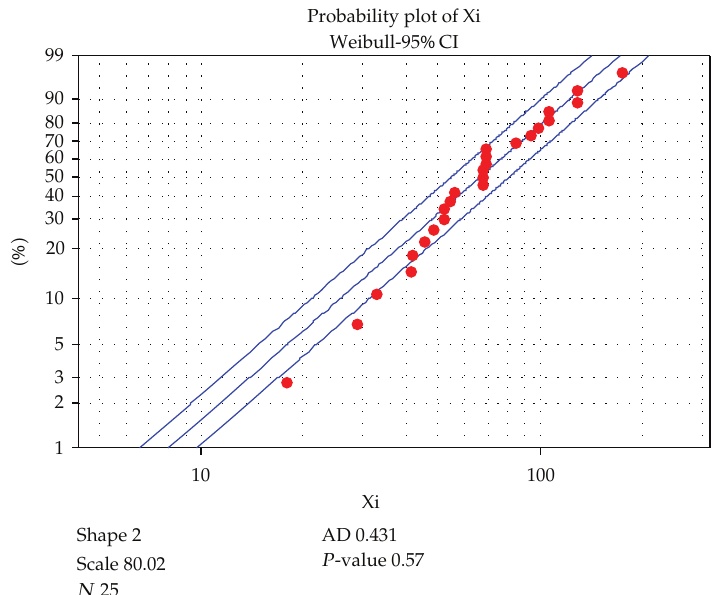
Figure 1: Probability plot for failure times of 25 ball bearings